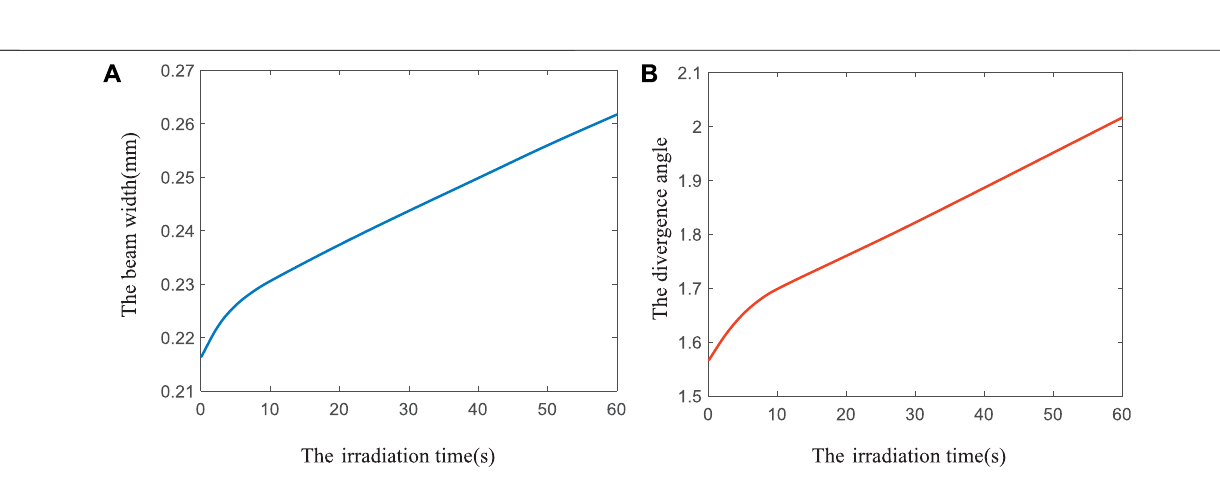
Frontiers in Physics |